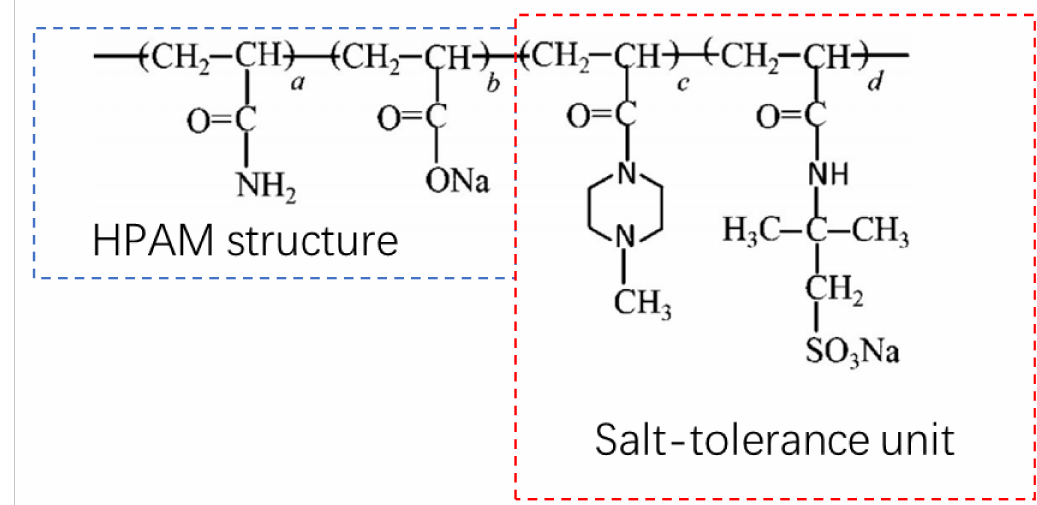
Figure 11. Salt-resistance polymer structure (revised after [133]).